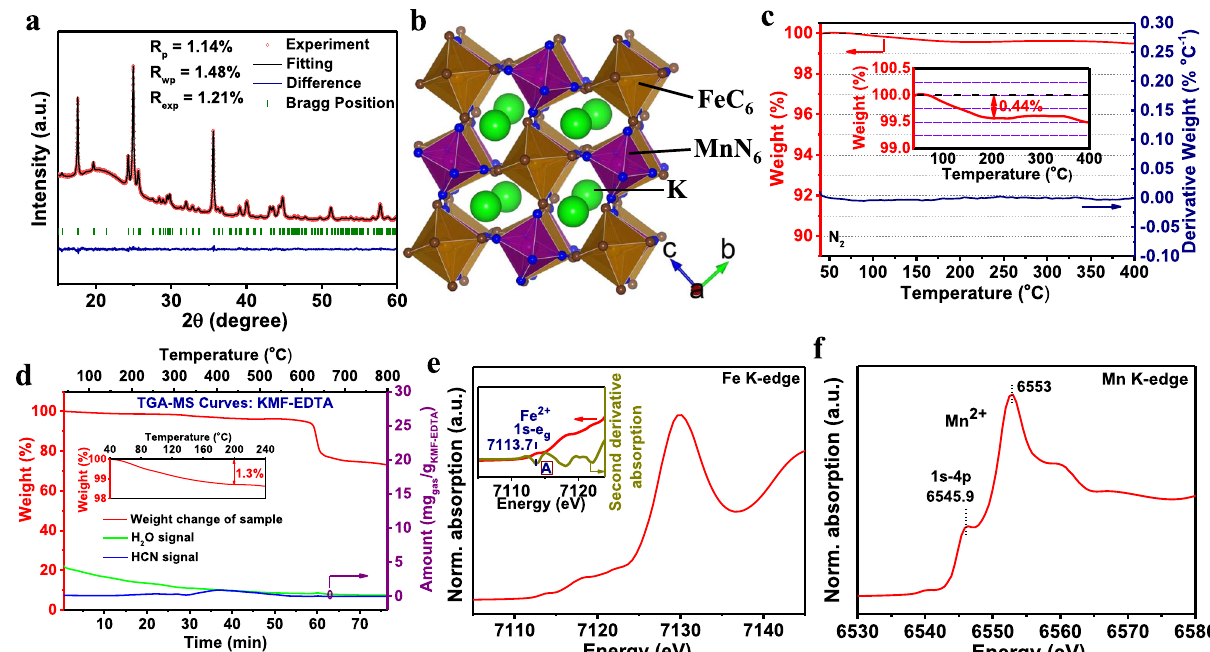
Fig. 2 Characterizations of KMF-EDTA. a , b Rietveld re fi nement XRD pattern ( a ) and the schematic crystal structure ( b ) of the KMF-EDTA sample. c TGA curve of KMF-EDTA sample tested in N 2 . d TGA-MS curves of the KFM-EDTA sample tested in N 2 after the sample is stored in room atmosphere (~25 ˚ C, relative humidity:40 – 60%) for 14 days. Note: the sample is stored immediately after the synthesis. e , f XANES spectra of the KMF-EDTA sample for the e Fe and f Mn K-edges. The inset in e shows the second derivative for the pre-edge region of the Fe K-edge spectrum. See Supplementary Fig. 7 and the corresponding text for the analysis of the oxidation state of Fe and Mn in the KMF-EDTA